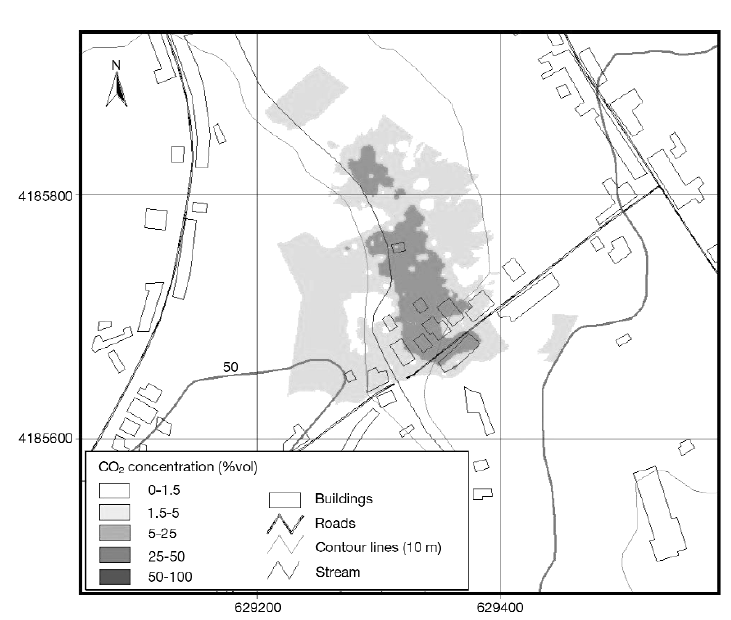
Fig. 8. CO 2 soil concentrations at Ribeira Seca in 1998, S. Miguel Island (modified from Ferreira,